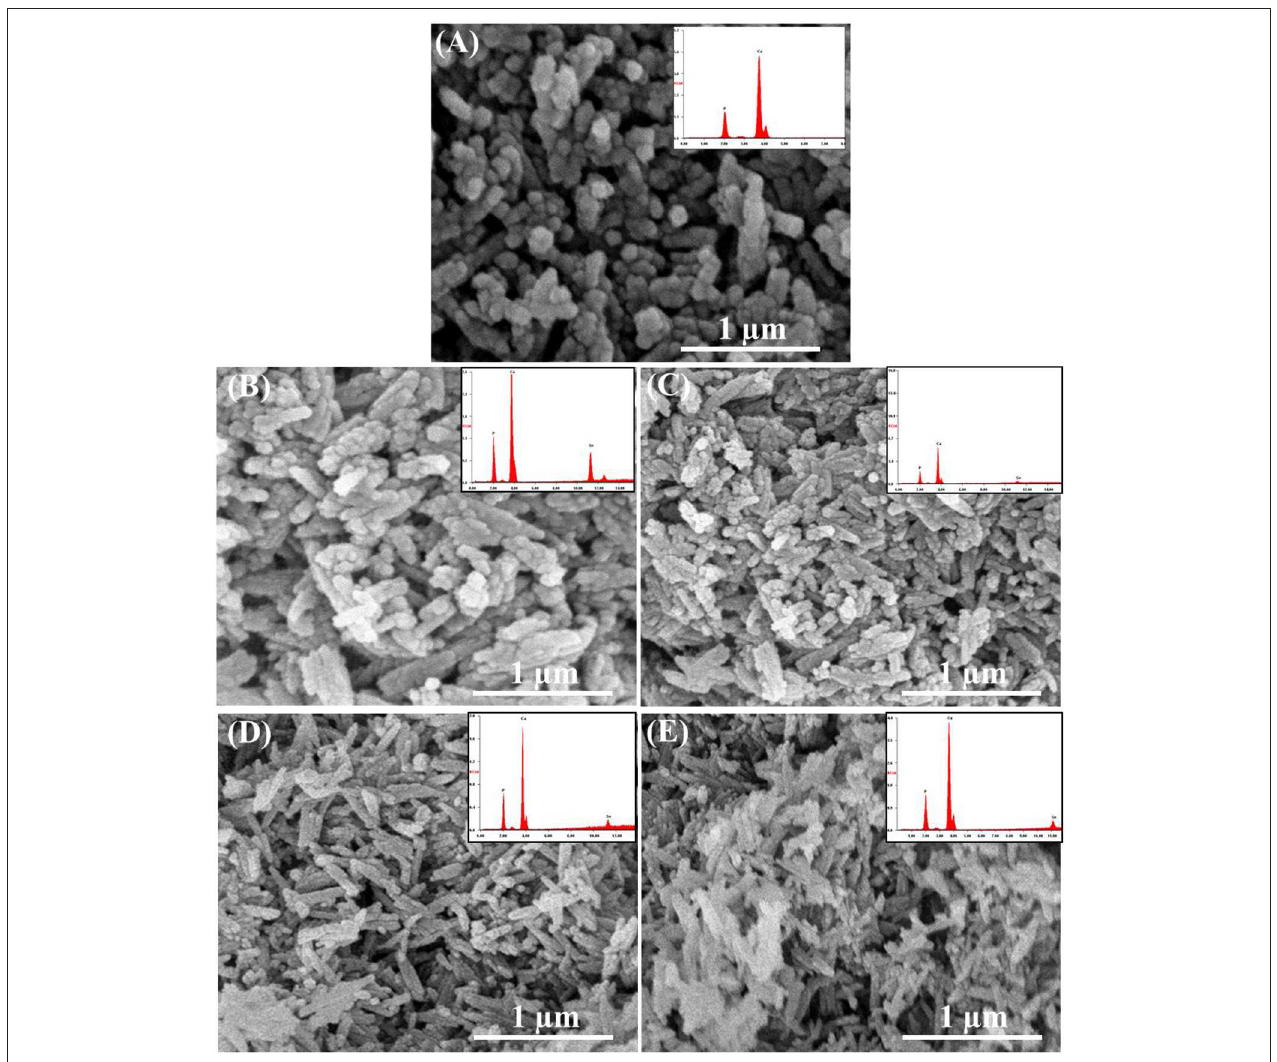
FIGURE 4 | Field-emission scanning electron micrographs and XRF spectra (inset) of (A) pristine HAp nanoparticles, and (B) Se-HAp, (C) CC/Se-HAp1, (D) CC/Se-HAp2, and (E) CC/Se-HAp3